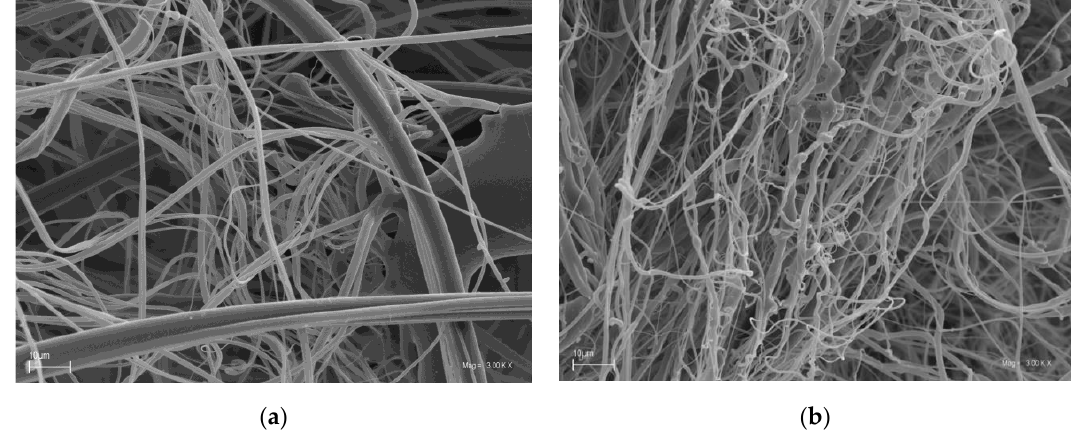
/ PET) and ( b ) MFM nonwoven (PP / PET / SAP / BH). Figure 1. SEM images of ( a ) CS nonwoven (PP/PET) and ( b ) MFM nonwoven (PP/PET/SAP/BH). Figure 1. SEM images of ( a ) CS nonwoven (PP